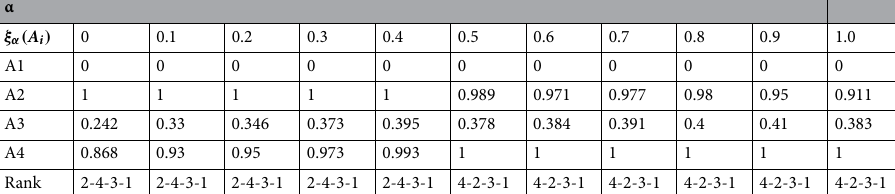
Table 5. The global dominance of alternatives for each α-cuts and rank of the alternatives for θ =